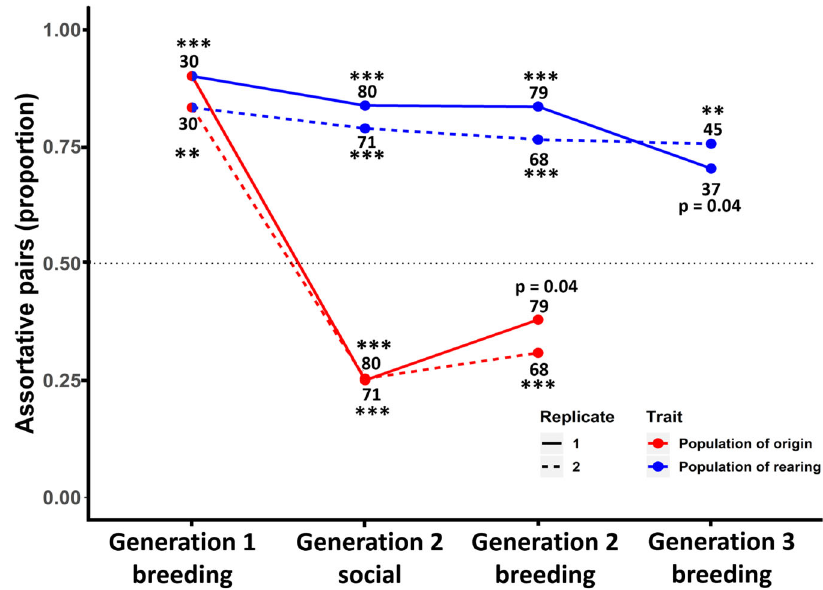
Fig. 2 Results of tests for assortative mating. Patterns of assortative mating over three experimental generations (see Supplementary Table 4 for exact p values). The y -axis shows the proportion of social pairs that were assortative with regard to traits that can only have been culturally transmitted such as song (blue) and traits that have been genetically inherited such as body size (red). The black dotted line marks the random expectation of 50% assortative pairs given an equal number of birds in each category. The two replicates, 1 and 2, are indicated by solid and dashed lines, respectively. The total number of pairs in each of the two replicates are indicated above or below the dots. *** p < 0.0001, binomial test, two-tailed; ** p < 0.001; * p < 0.01. In Generation 1, where populations differed culturally and genetically, most individuals paired assortatively by population. In Generation 2, after cross-fostering, individuals mated assortatively by cultural background (population of their rearing parents) and disassortatively by genetic background (population of origin). In Generation 3, where tests were carried out within each genetic background but included groups that differed in cultural background, pairs formed assortatively by cultural as opposed to genetic (Supplementary Fig. 6). Analysis of daily social networks within and between sexes revealed that the patterns of assortment by song and dis-assortment by population of origin occurred only between sexes (Fig. 6a) but not among same-sex individuals (Fig. 6b), and that the patterns gradually emerged and strengthened over the course of the experiment (Fig. 6a). This indicates that the populations were initially well-mixed and remained well-mixed in terms of same-sex relationships, but separated over time due to mate choice. The sex-speci fi city of the pattern suggests that the population separation was caused by mate choice, rather than by a hypothetical alternative mechanism based on differences in same-sex familiarity.